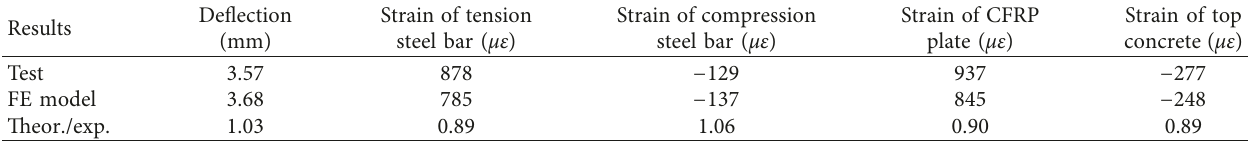
Table 4: Immediate response at midspan of the test beam.